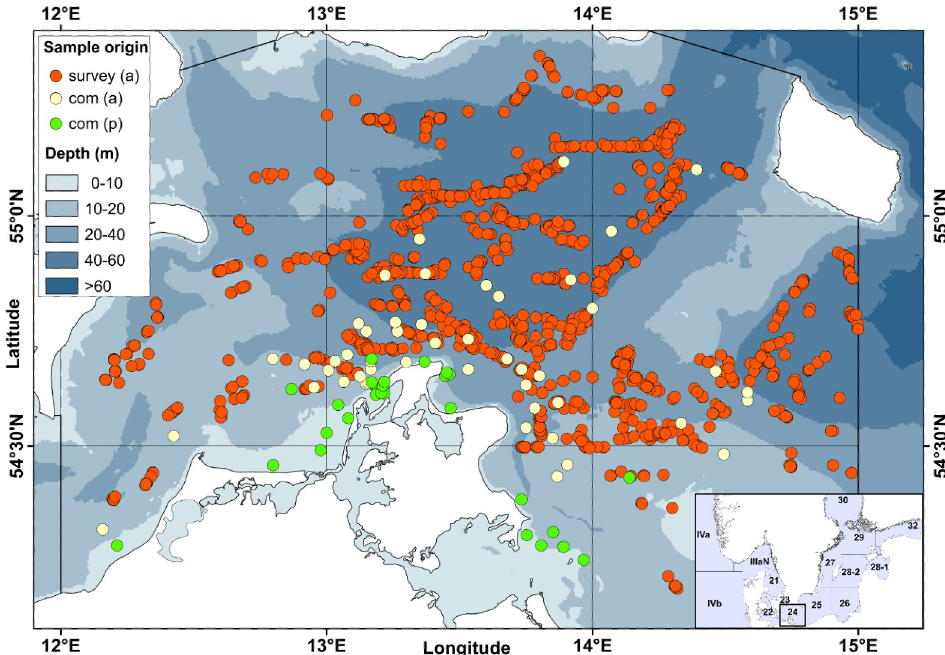
Fig 1. Sampling locations of Baltic cod in SD 24. Cod samples originate from bottom-trawl survey catches (1977 to 2019) and commercial (= com) catches (2010 to 2019) using active (= a) and passive (= p) fishing gears. Inset is a map of the larger Baltic Sea region, indicating ICES subdivisions 22 (Belt Sea), 23 ( Ø resund), 24 (Arkona Sea) and 25 (Bornholm Basin). Grid within SD 24 represents ICES statistical rectangles. Source of elevation data from [41].